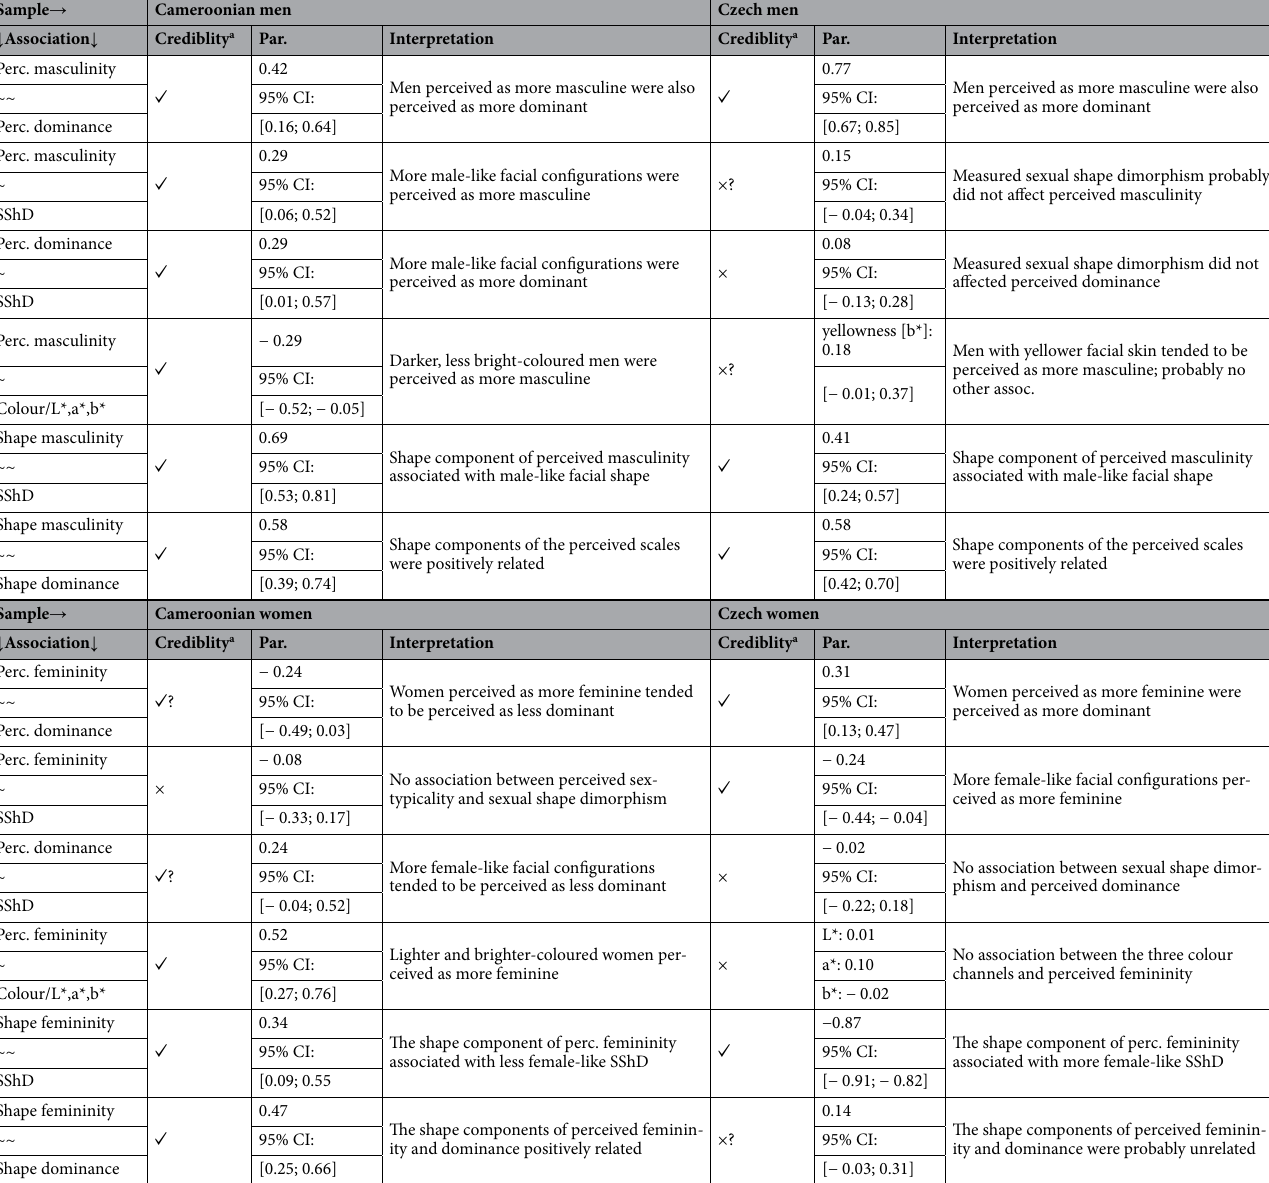
Table 2. Summary of selected bivariate associations. a Once the 95% credibility interval of posterior probability density distribution of bivariate coefficients did not contain zero, we interpreted it as credible (we assume that the coefficient is in fact non-zero) and marked by ‘ ✓ ’. Borderline coefficients (CI containing zero but majority of the mass of the distribution above/below zero are marked with ‘ ✓ ?’. Credibility does not correspond to the direction of association (cf. Discussion where the results are being addressed with regard to hypotheses); Par. = Parameter value. 1st to 4th coefficients for each of the sample’s regression coefficients based on ‘default’ models without shape dominance and shape sex-typicality, 5th and 6th coefficients are residual covariances based on models with both shape dominance and shape sex-typicality. Relationships marked with ~~ are modelled as correlational; ~ indicates regression